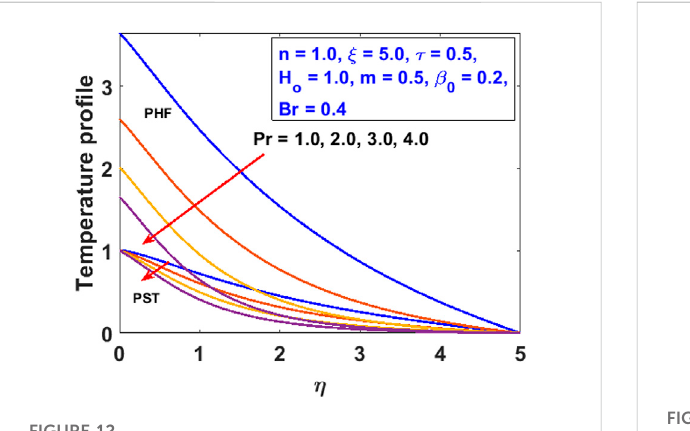
FIGURE 15 Effects of Rd on temperature.